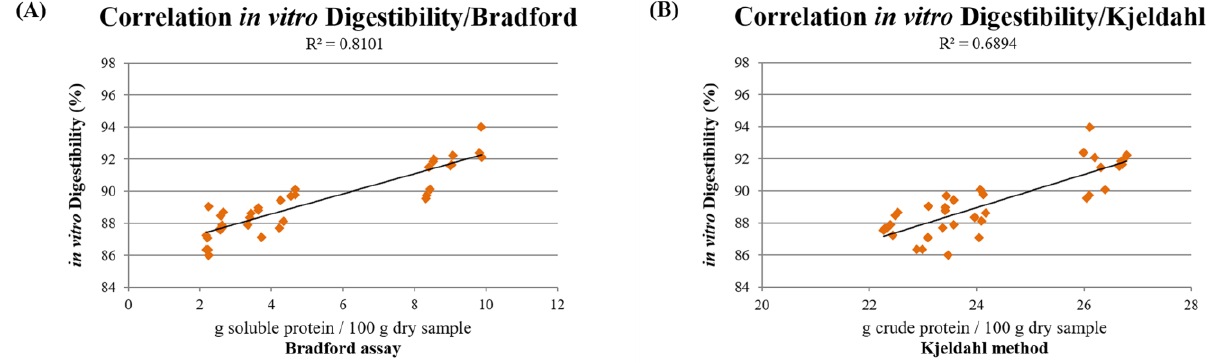
Figure 7. ( A ) Correlation between the in vitro digestibility assay and the soluble protein content evaluated by the Bradford assay in CFM, CMix, and CMM formulations for companion animal food. ( B ) Correlation between the in vitro digestibility assay and the crude protein content evaluated by the Kjeldahl method in CFM, CMix, and CMM formulations for companion animal food. Data are reported as mean ± SEM, n = 12.